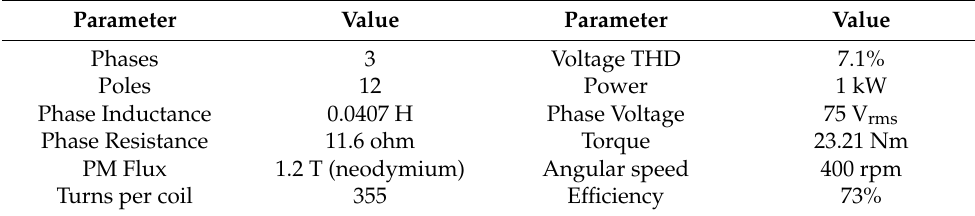
Table 1. Characteristics of the PMSG.